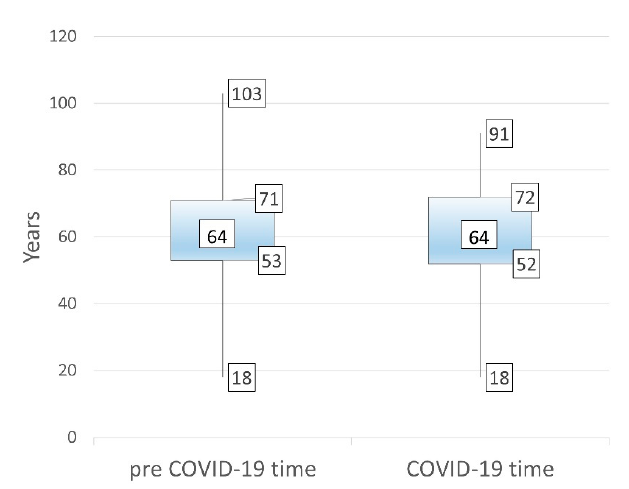
Figure 1. Median values of the age of the patients before and during the COVID-19 period.